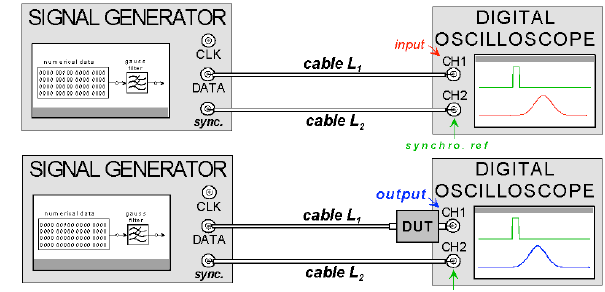
Figure 10: Diagram of the experimental setup [41].